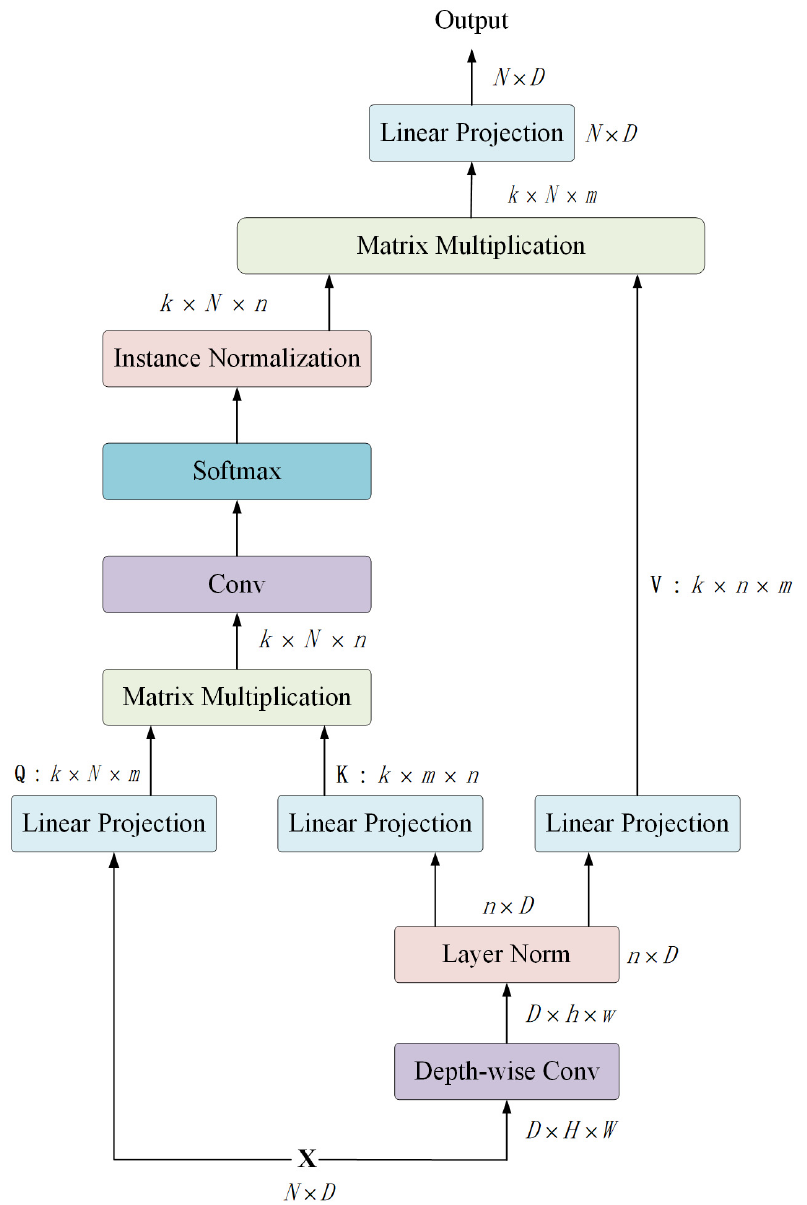
Figure 3. The flowchart of efficient multi-head self-attention. Here, Conv is a standard 1 × 1 convolution with a stride of 1. IN denotes an instance normalization operation. LP represents a linear projection that keeps a dimension of D